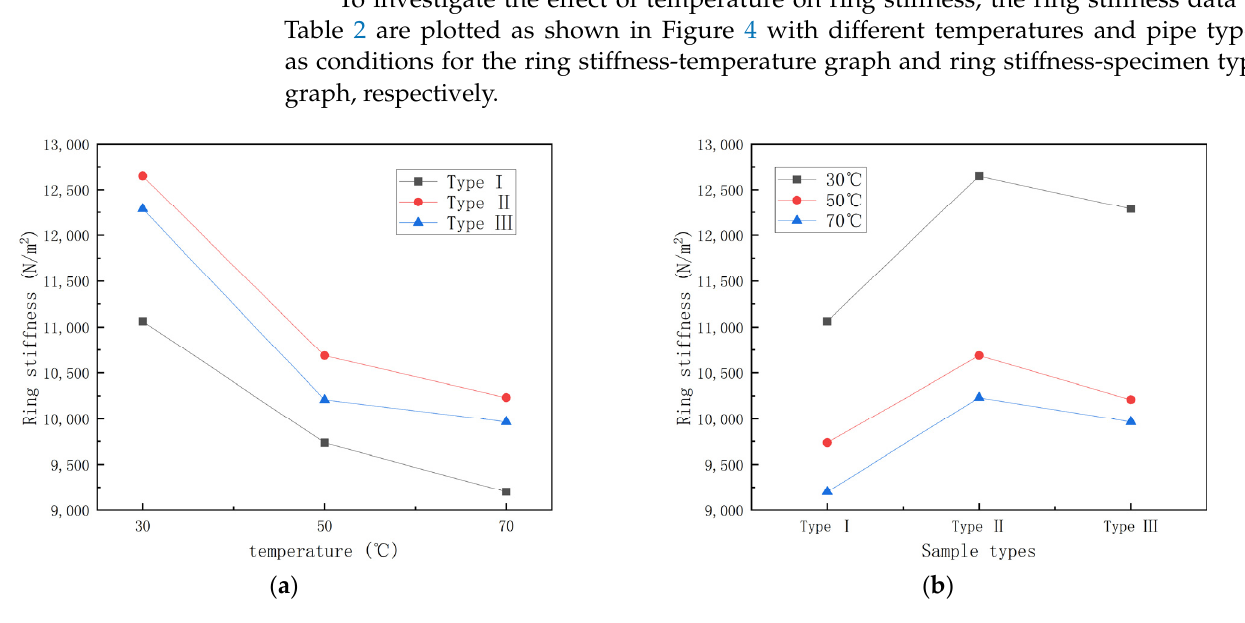
Figure 4. GFRP pipe ring stiffness curve. ( a ) Ring stiffness—temperature curve; ( b ) Ring stiffness— sample type curve.